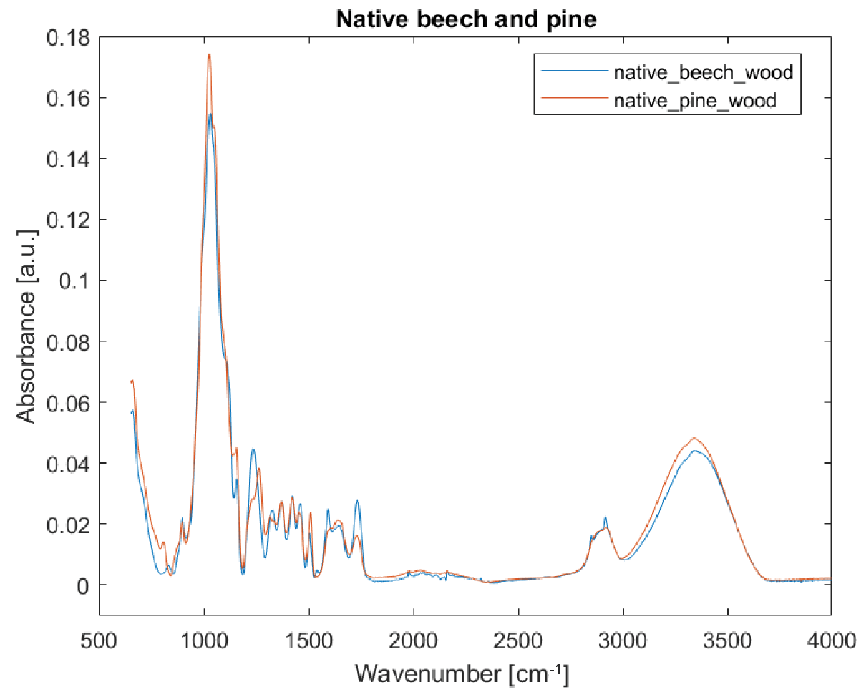
Figure 6. FTIR-ATR spectra of native (blue) beech and (red) pine wood reference